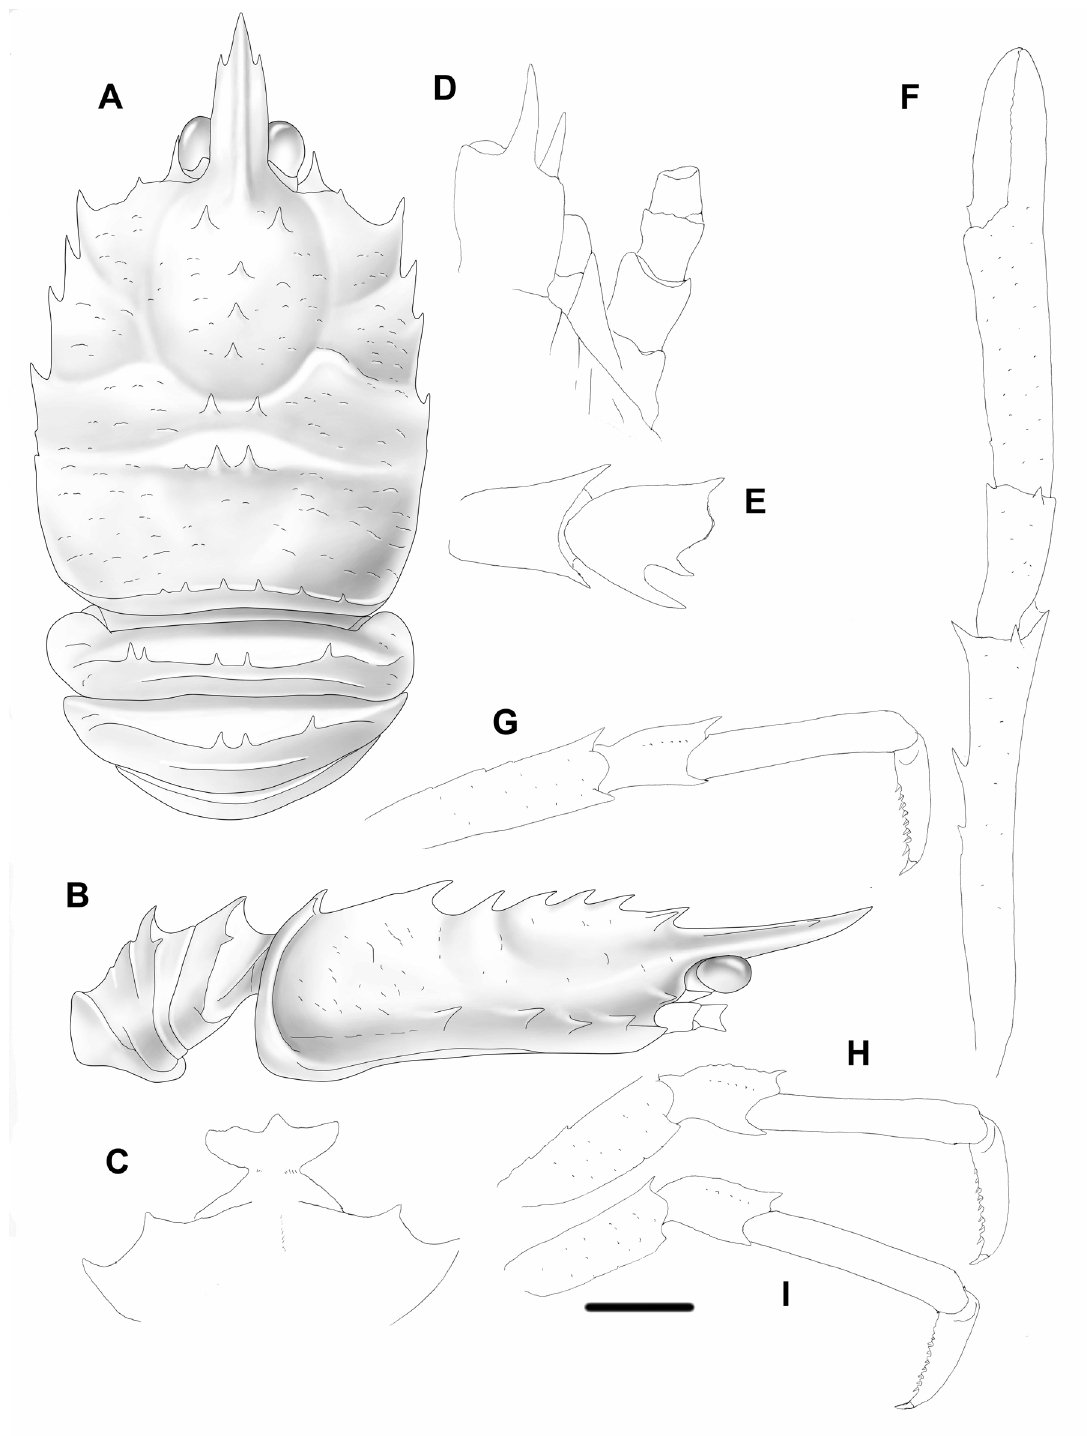
Fig. 10. Munidopsis columbae sp. nov., holotype, ♂, 8.7 mm (MNHN-IU-2014-13472), Madagascar. A . Carapace and abdomen, dorsal view. B . Carapace and abdomen, lateral view. C . Sternal plastron, sternites 3 and 4. D . Cephalic region, showing antennular and antennal peduncles, ventral view. E . Right Mxp3, lateral view. F . Right P1, dorsal view. G . Right P2, lateral view. H . Right P3, lateral view. I . Right P4, lateral view. Scale bar: A–B, F–I = 2.0 mm; C–E = 1.0